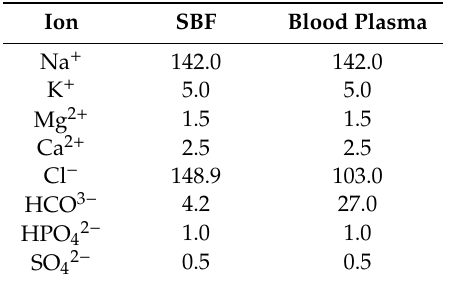
Table 1. Ion concentration (mM) of SBF and human blood plasma [30].